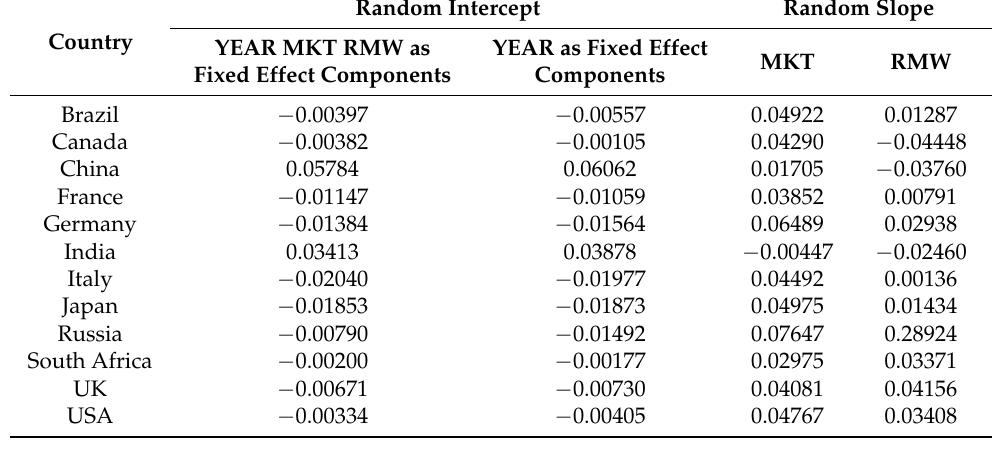
Table 11. Expected Values of Intercepts of Random Effects by Country Estimated by Linear Trend Models of Explanatory Variables YEAR, MKT and RMW in the Fixed Effects Component and with- out MKT and RMW in the Fixed Effects Component, but rather in the Random Effects of the Slopes.